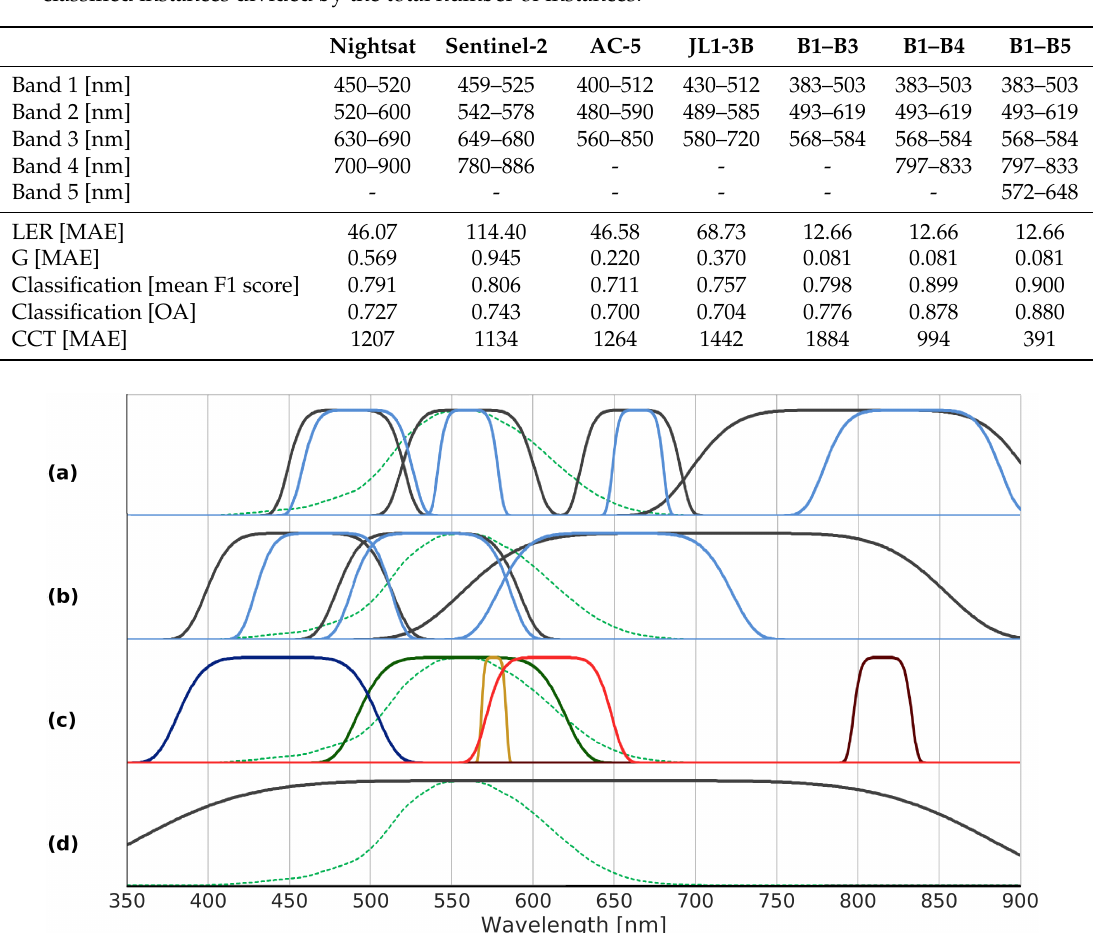
Figure 6. Dashed green line: CIE photopic spectral luminous efficiency V ( λ ) ; ( a ) black lines: Nightsat bands, blue lines: Sentinel-2 bands; ( b ) black lines: AC-5, blue lines: JL1-3B bands; ( c ) optimized bands B1–B5; ( d ) optimized panchromatic band